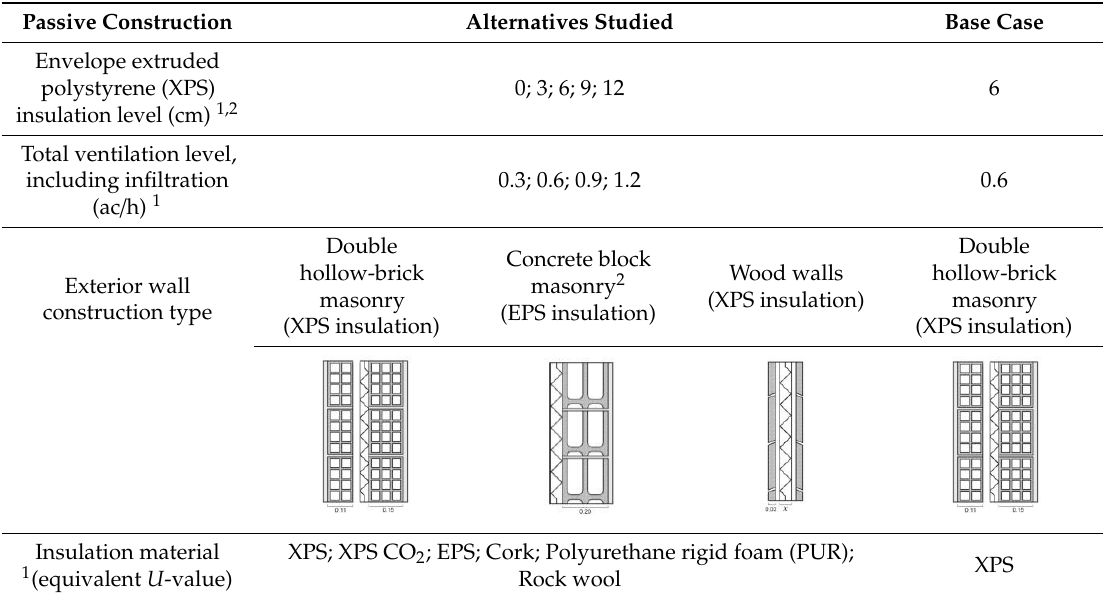
Table 3. Envelope construction alternatives and base case.